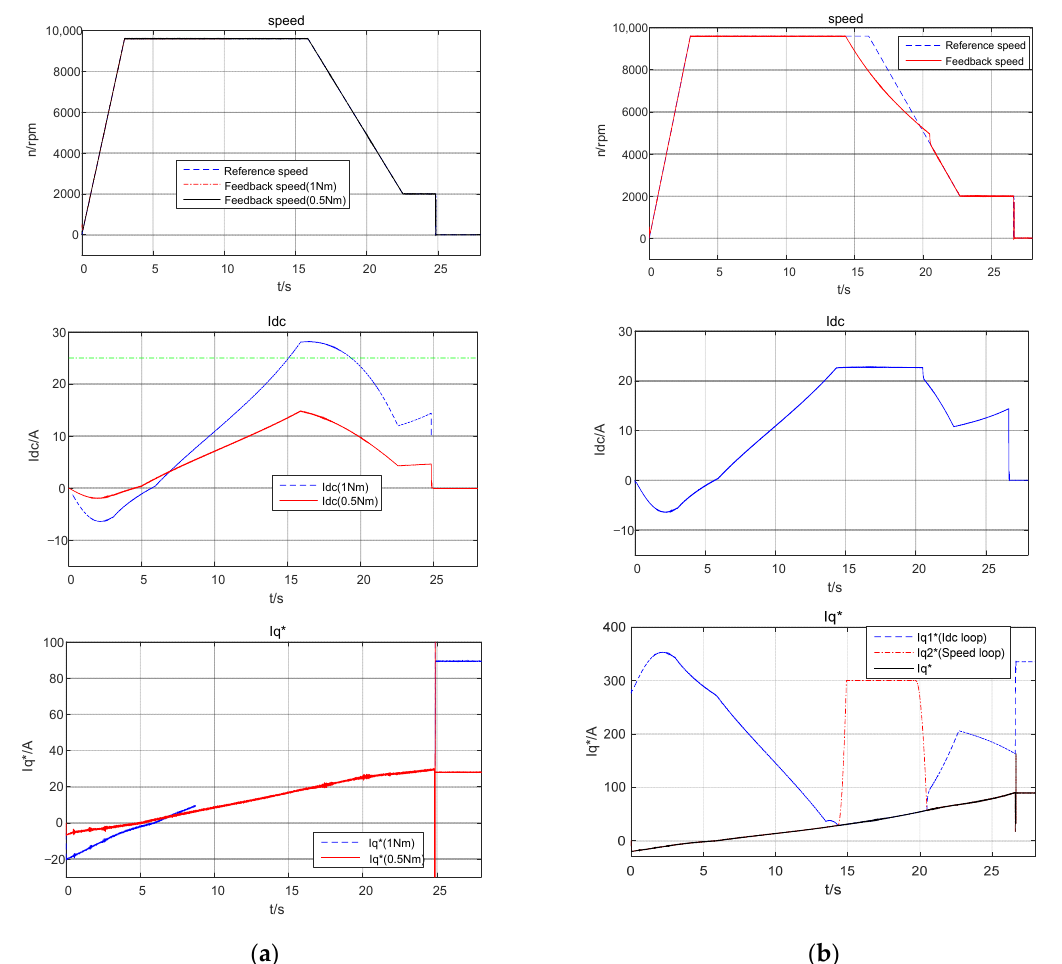
Figure 8. Simulation results of speed, I dc , and I q ∗ . ( a ) Speed loop control when the load torque is 0.5 Nm and 1 Nm; ( b ) Hybrid control strategy when the load torque is 1 Nm.